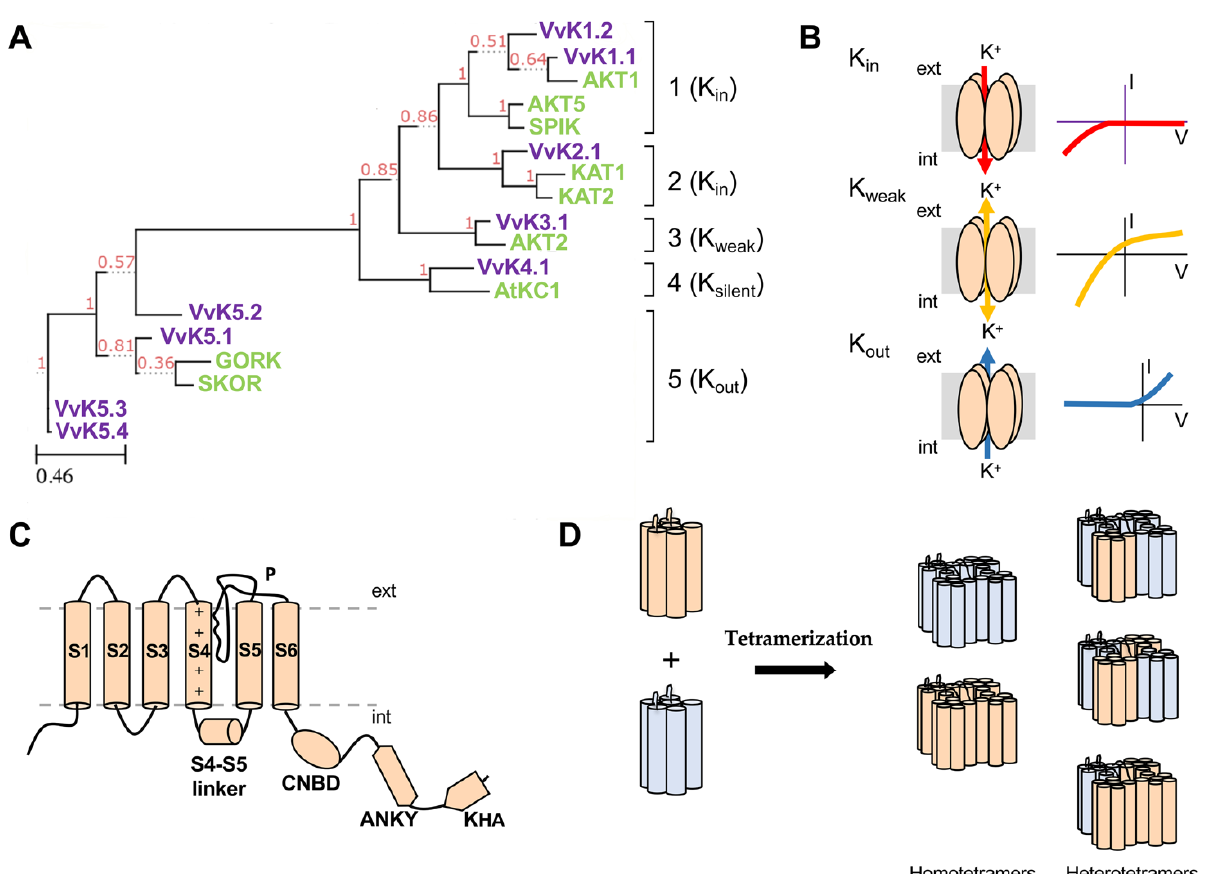
Figure 1. The Shaker K + channel family. ( A ) Phylogenetic relationships in the grapevine (in green) and A. thaliana (in blue) Shaker K + channel families. The Shaker family displays five groups in plants [115] named 1 to 5. Accession references are listed in Table 1. The abbreviations K in , K out K weak , and K silent are explained in the legend of Table 1. To find the conserved region, A. thaliana and grapevine Shaker polypeptide sequences were first aligned using MUSCLE 3.8.31 in full mode and then treated with Gblocks for alignment curation. The phylogenetic analyses were carried out using maximum likelihood with Phy ML 3.1/3.0 aLRT software. Tree rendering was performed using the tree drawing engine ETE 3 [116]). Bootstrap values are indicated at the corresponding nodes. The scale bar corresponds to a distance of 4,6 changes per 100 amino acid positions. ( B ) Functional Shaker channels are multimeric proteins formed by the assembly of four Shaker subunits. Current–voltage (I–V) curves illustrate the functional types found in the homotetrameric Shaker channels that form inwardly rectifying, weakly inwardly rectifying, or outwardly rectifying conductances. Int and ext: internal and external face of the plasma membrane. ( C ) Structural domains of a Shaker channel subunit. S1 to S6: transmembrane segments, CNBD: cyclic nucleotide-binding domain, ANKY: ankyrin domain (involved in protein-protein interactions, not found in all Shaker subunits), KHA: hydrophic and acidic domain. ( D ) Assembly of four Shaker alpha-subunit is a prerequisite for channel functioning. Three-dimensional representation of S1–S6 segments in a single subunit (left) or Shaker tetramers (right). Subunits are encoded either by the same gene (homotetrameric channel) or by different genes (heterotetrameric channel). K in sub-units (Groups 1, 2, 3 and 4 in A) assemble as K in channels, whereas K out sub-units (Group 5) form K out channels. No assembly could be detected between K in and K out channel subunits [117]. Stoichiometry studies have revealed the various possible combinations between the different subunits